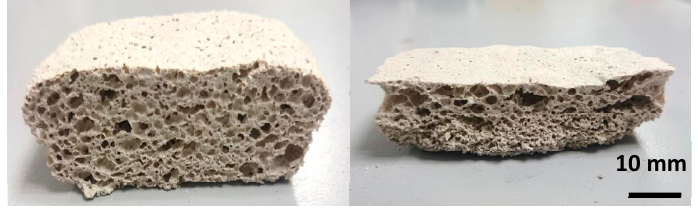
Figure 3. Cross section of MKBM50 (left) and MKBM75 (right) samples.